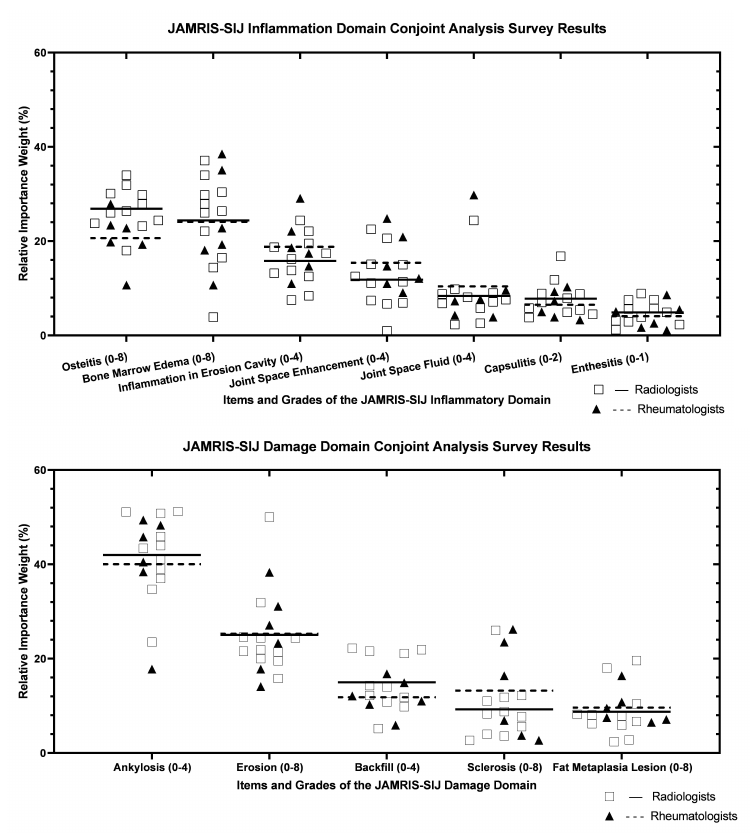
Figure 1. ( A , B ) Scatter plots of item weights derived from the conjoint analysis survey (CAS)-derived weights. ( A ) Scatter plots of inflammation domain item weights derived from the conjoint analysis survey (CAS)derived weights. Relative weights from all participants are plotted for each of the JAMRIS-SIJ inflammation domain items, with lines representing the median weight for radiologists (Square marker and solid line n = 11) and rheumatologists (triangular and broken line, n = 6). ( B ) Scatter plots of the damage domain item weights derived from the CAS-derived weights. Relative weights from all participants are plotted for each of the JAMRIS-SIJ damage domain items, with lines representing the median weight for radiologists (Square marker and solid line n = 11) and rheumatologists (triangular and broken line, n =